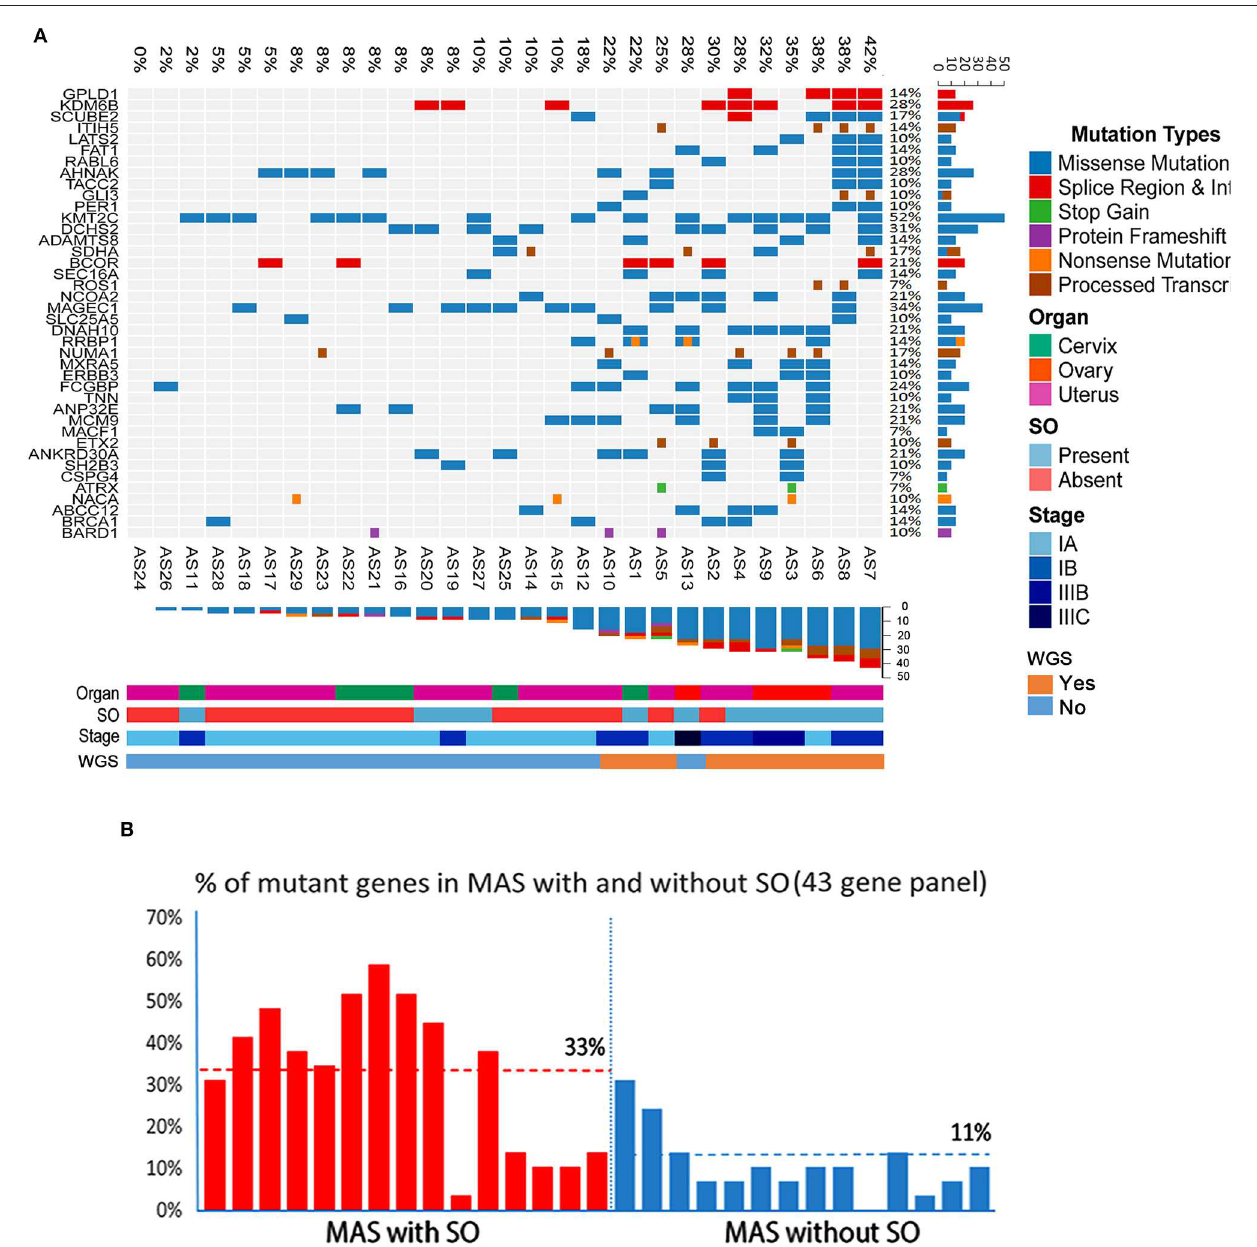
FIGURE 6 | Landscape of frequent mutations of genes in Müllerian adenosarcoma (MAS). (A) Target validation of the gene mutation types and distribution of 43 oncogenes/tumor suppressors in 29 MAS by next-generation sequencing (NGS). Rows represent individual genes and columns represent individual tumors. Mutated genes are sorted according to frequency in this cohort. Colors indicate the mutation type detected in each tumor. (B) Histoplots illustrate the percentage of 43 mutant genes in MAS with sarcomatous overgrowth (SO, red bars) and without SO (blue bars).